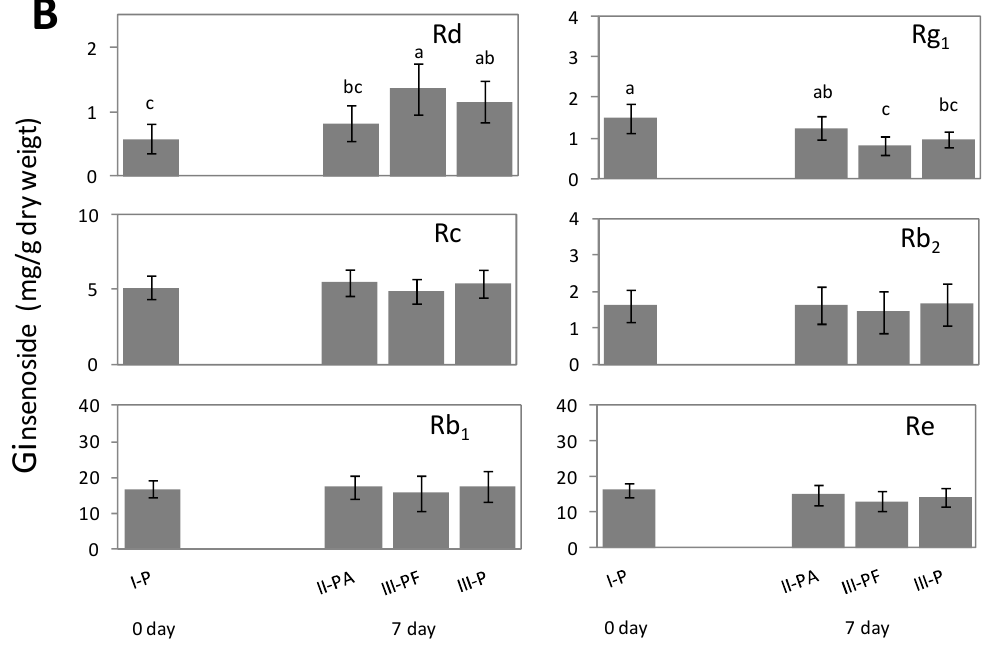
Figure 4. Contents of ginsenoside Rg , Re, Rb , Rc, Rb , and Rd of American ginseng 1 1 2 roots detected using HPLC in phloem tissues of the three parts (I, II, and III), including untreated (I-P), PDA-plugged (II-PA), Fusarium culture (III-PF) and untreated area adjacent to Fusarium culture (III-P). Samples were collected at 0 and 7 days after inoculation with ( A ) Fusarium solani ; and ( B ) F. oxysporum . Mean values followed by the same letter or no letter were not significantly different ( p < 0.05) in each ginsenoside (a panel in the figure), while followed by different letters were significantly different ( p > 0.05), analyzed using Fisher’s least significant difference (LSD)